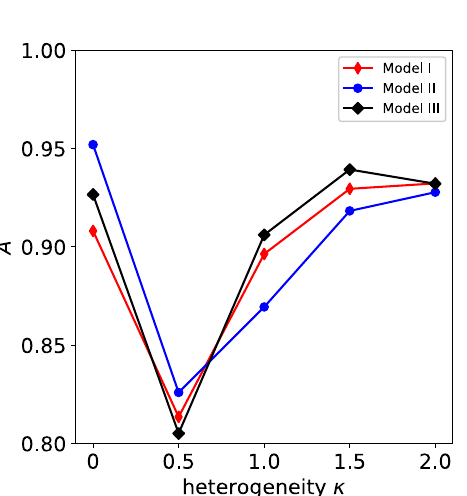
Figure 11. Average path-wise stress error E σ (calculated over 20 different pseudo-random loading paths) as a function of the heterogeneity κ and the number of training data points φ . Data are shown for models I, II and III.